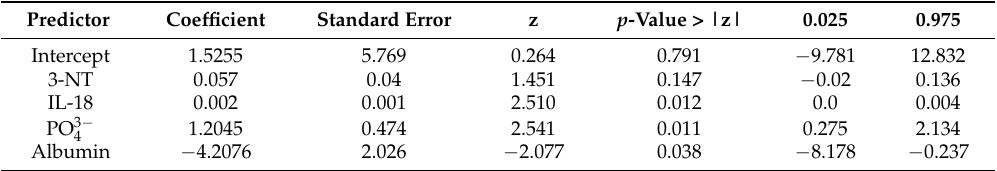
Table 5. The Wald test results for the chosen combination of predictor variables (3-NT, IL-18, PO 3 − and Albumin). The more that the z value is away from 0, the more likely it is that excluding the analyzed variable will significantly harm the model. The 0.025 and 0.975 columns show boundaries for a 95% confidence interval for the